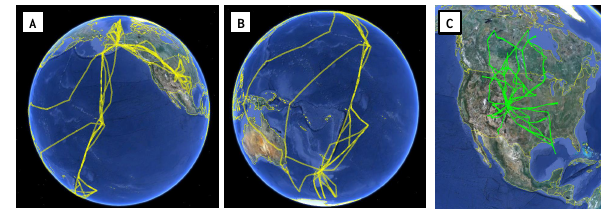
Fig. 1. Google map of START08 and HIPPO flights analyzed in this study. Yellow lines represent flight tracks of HIPPO campaign 1–5 and green lines represent the flight tracks of research flights 4–18 (RF04–RF18) in START08.